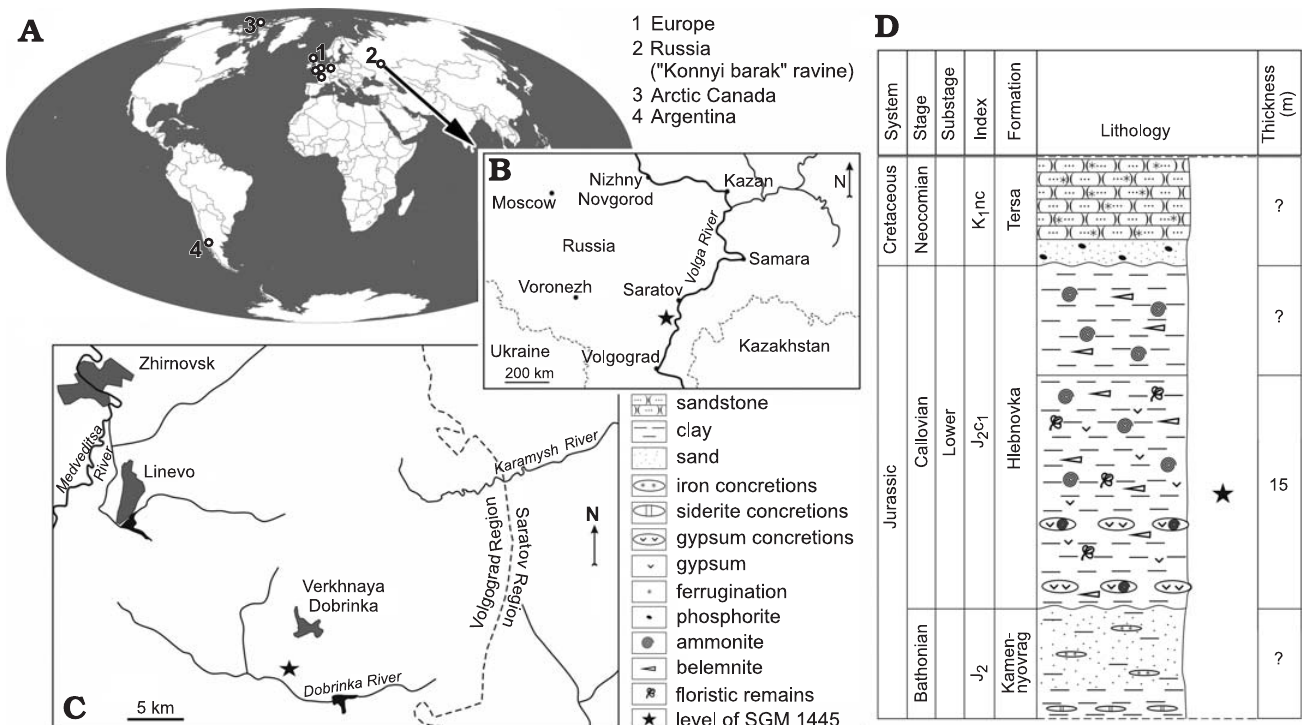
Fig. 1. Global map showing Callovian plesiosaurian localities ( A ), with further information on the geographic (regional map, B ; local map, C ) and strati- graphic ( D ) context of “Konnyi barak” ravine, from which SGM 1445-9–20, 97 − 120 was collected. Global map was constructed using